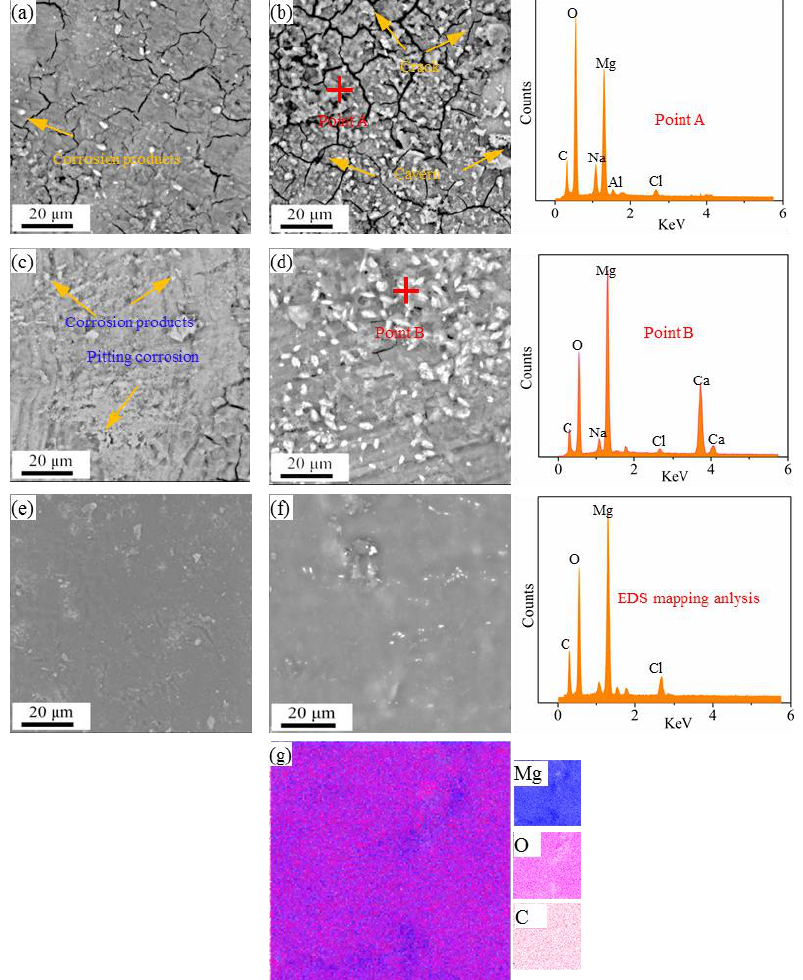
Figure 5. SEM in conjunction with EDS was used to study the surface morphologies and the distributions of elements during immersion tests: SEM images with EDS analysis of ( a ) AZ91, ( c ) AZ91S, and ( e ) AZ91SG after immersion for 24 h; ( b ) AZ91, ( d ) AZ91S, and ( f ) AZ91SG after immersion for 72 h, respectively. ( g ) United Mg O, and C element distributions on AZ91SG after immersion for 72